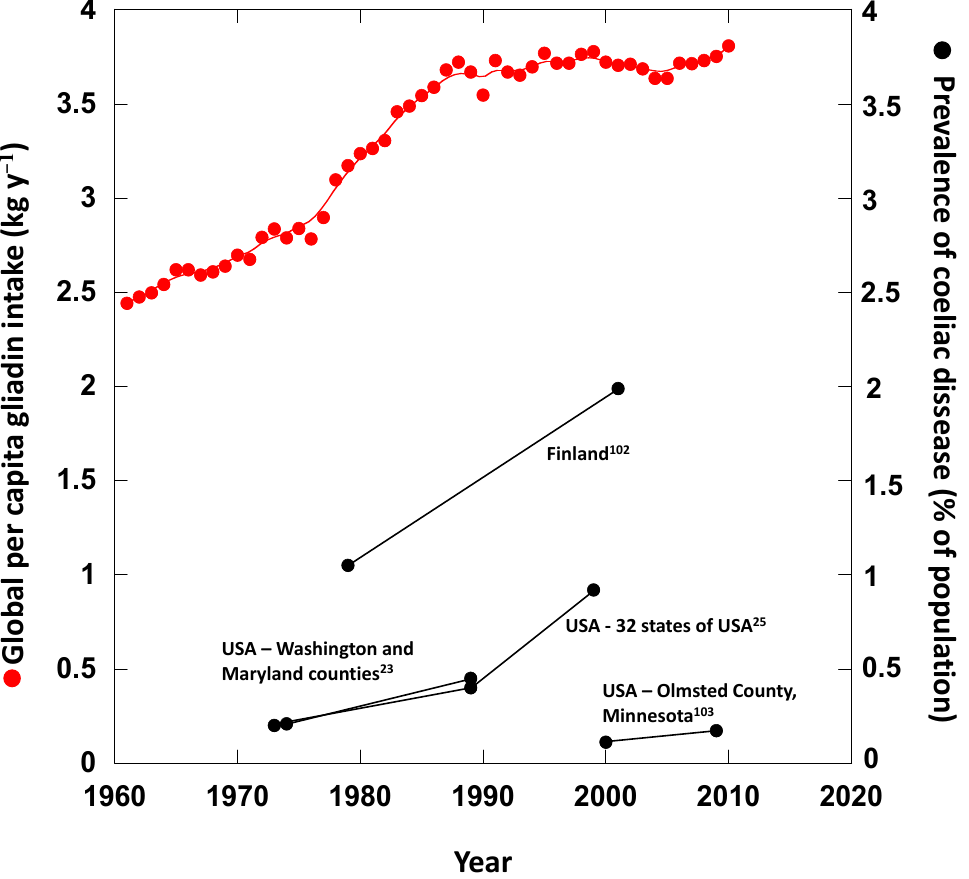
Figure 5. Changes in global per capita intake of gliadins, global per capita intake of gliadins per kg of N fertilisation, amount of N fertilizer applied per tonne of harvested wheat grains and the prevalence (percentage of coeliac cases in the total population) or incidence (new cases per 1000 inhabitants and year) of coeliac disease from studies with large and representative sets of population data, adjusted for age and sex, from 1961 to 2010 [23,25,102,103].